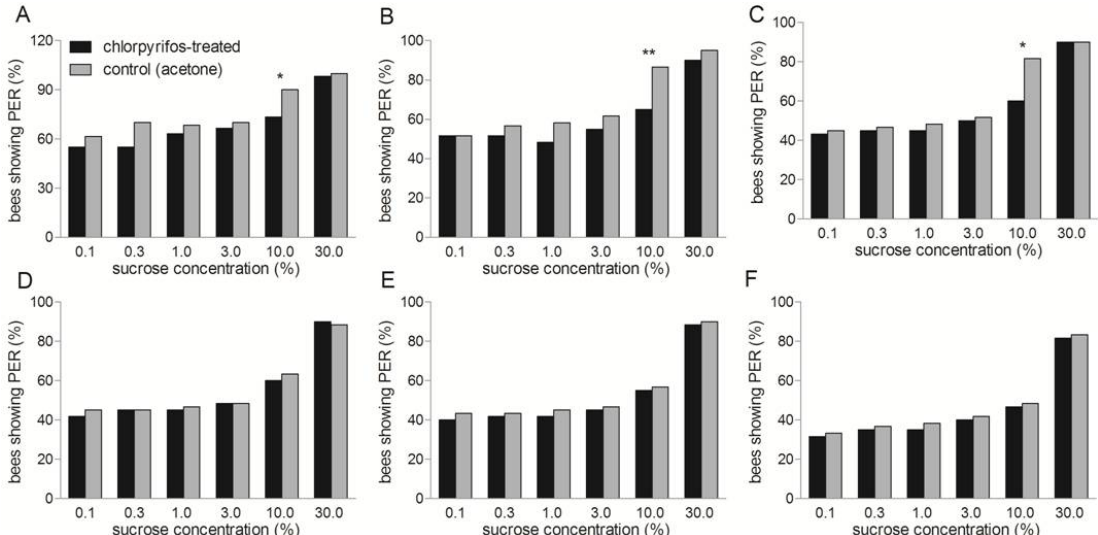
Fig 1. Analysis of sucrose responsiveness in honey bees exposed to sublethal doses of chlorpyrifos. Response of honey bees (Top: A. mellifera ; bottom: A. cerana ) treated with sublethal oral doses of chlorpyrifos to serial sucrose solutions after 2 h (A and D), 24 h (B and E) and 48 h (C and F ) exposure. Control bees received acetone. Asterisks denote significant differences: one, p<0.05; two, p<0.01.